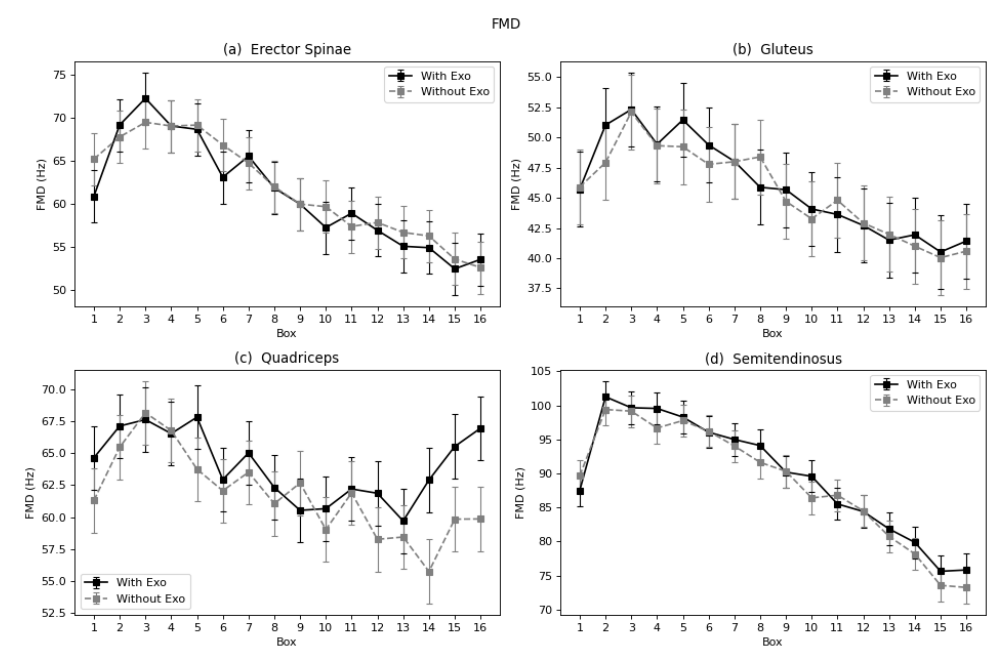
Figure 7. Marginal mean curves with the standard error bars of FMD parameter throughout the 16 boxes for all four muscles: ( a ) Erector Spinae, ( b ) Gluteus, ( c ) Quadriceps, and ( d )